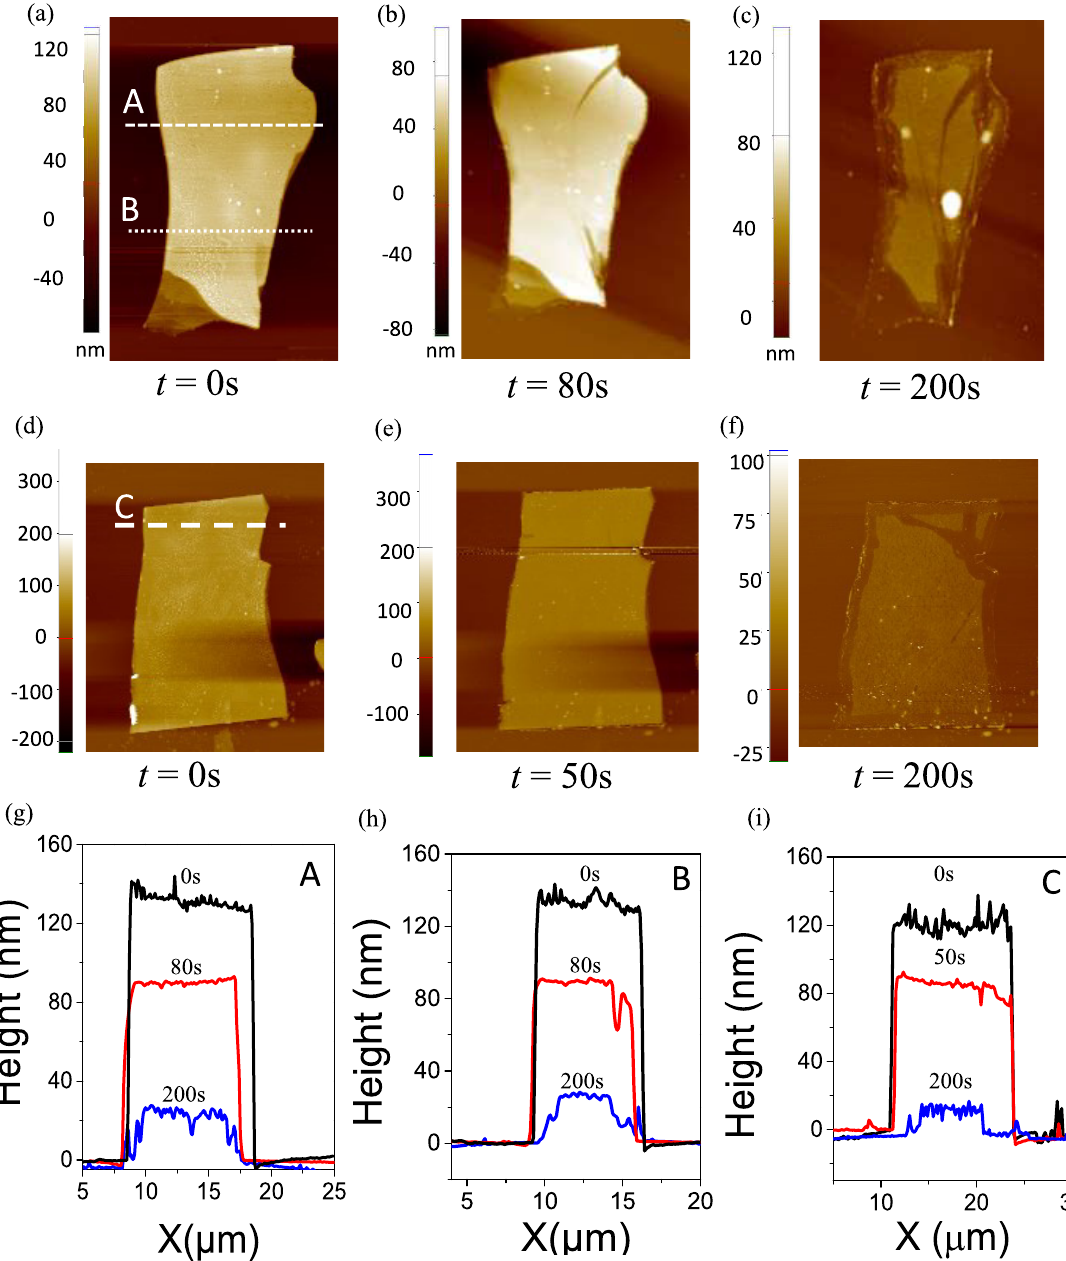
Figure 4: Atomic force microscopy (AFM) topographic maps showing the morphology of a pulsed thermally annealed (a – c) 135 nm nanosheet and (d – f) 120 nm nanosheet. (g – i) AFM cross-sectional data as a function of treatment